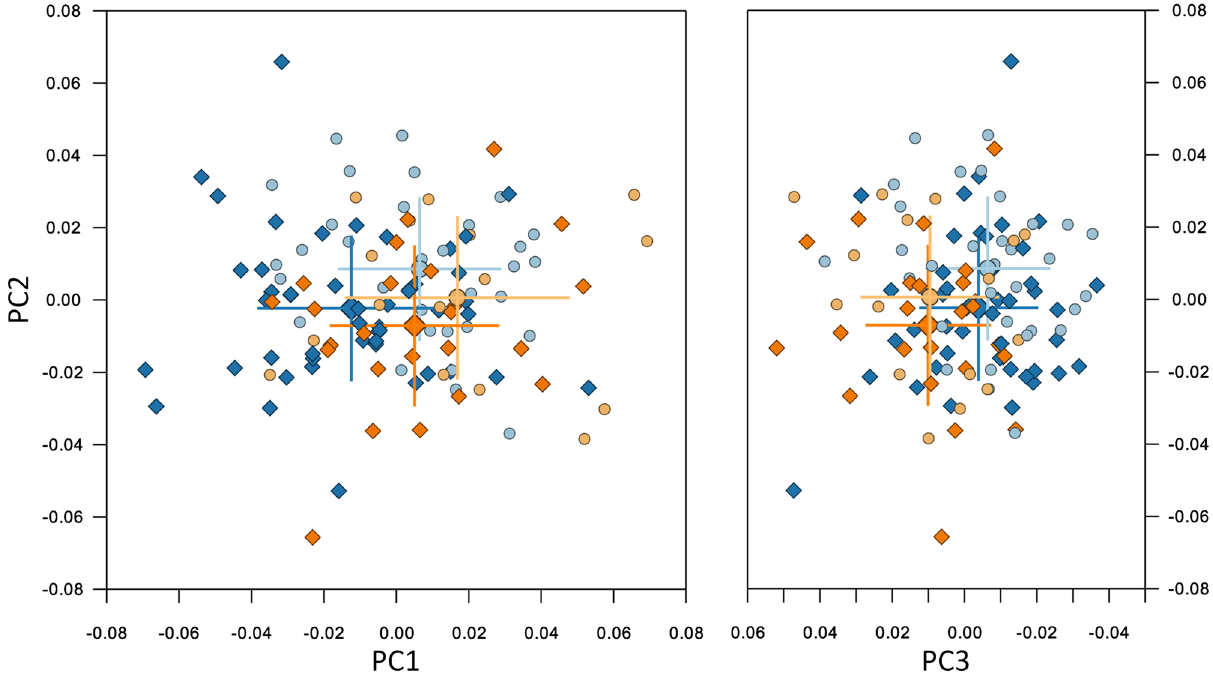
Figure 10. Shape space of the Mnd region. Blue and light blue: control subjects; orange and light orange: βTh group. Circles: females; diamonds: males. Large markers show group means and standard deviation.